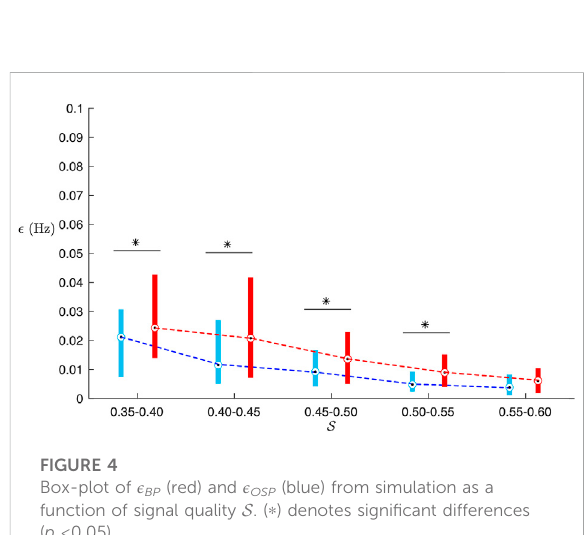
FIGURE 5 Mean estimation error ϵ OSP (red) and ϵ BP (blue) from simulations plotted versus the magnitude of respiratory modulation Δ F